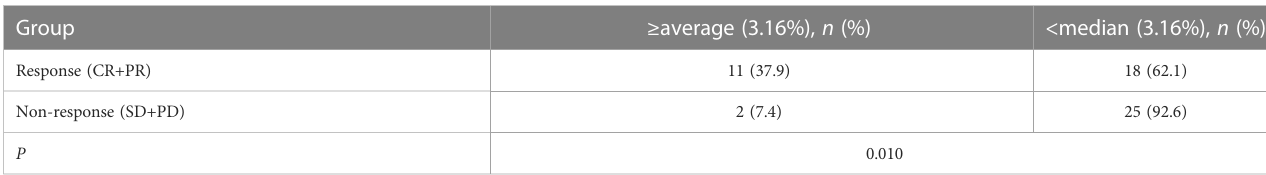
TABLE 7 Association between the abundance of EGFR T790M (average) and the curative effective of the third generation of EGFR tyrosine kinase inhibitors. Group